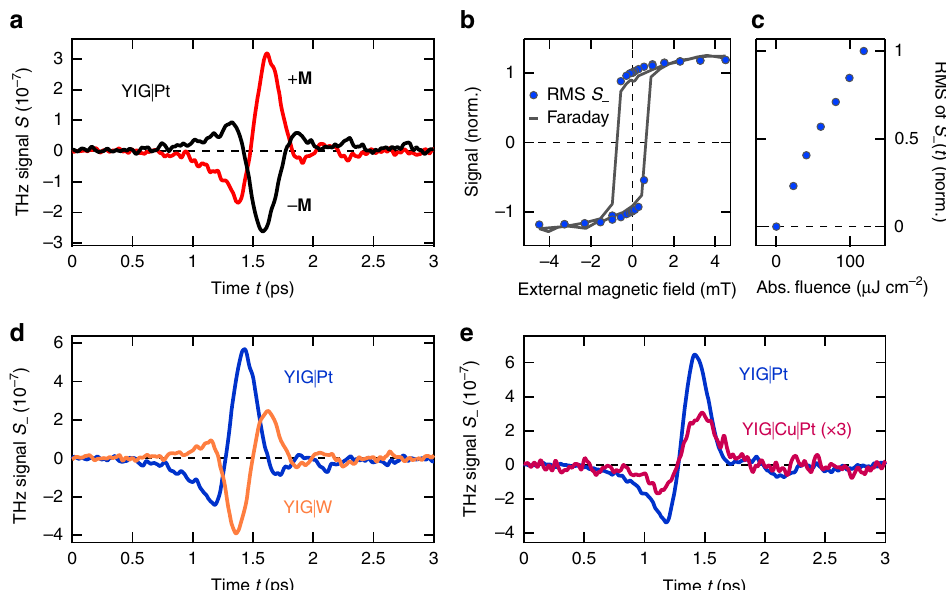
Fig. 2 Terahertz emission of photoexcited F|N bilayers. a THz emission signals S (± M ) from a YIG(3 µ m)|Pt(5.5 nm) sample for opposite directions of the in-plane YIG magnetization M as a function of time t . We focus on the difference S _ = S ( M ) − S ( − M ) odd in M . b Amplitude of the THz signal S − (root-mean-square, RMS) and the Faraday rotation of a continuous-wave laser beam (wavelength 532 nm) as a function of the external magnetic Both hysteresis loops were measured under identical pump conditions at room temperature. c Amplitude of S − as a function of the absorbed pump fl uence. d THz emission signal from a 3 µ m thick YIG fi lm capped with Pt and W, both 5.5 nm thick. e THz emission signal from a 5 µ m YIG fi lm capped with Pt(5.6 nm) or Cu(1.9 nm)|Pt(5.4 nm)